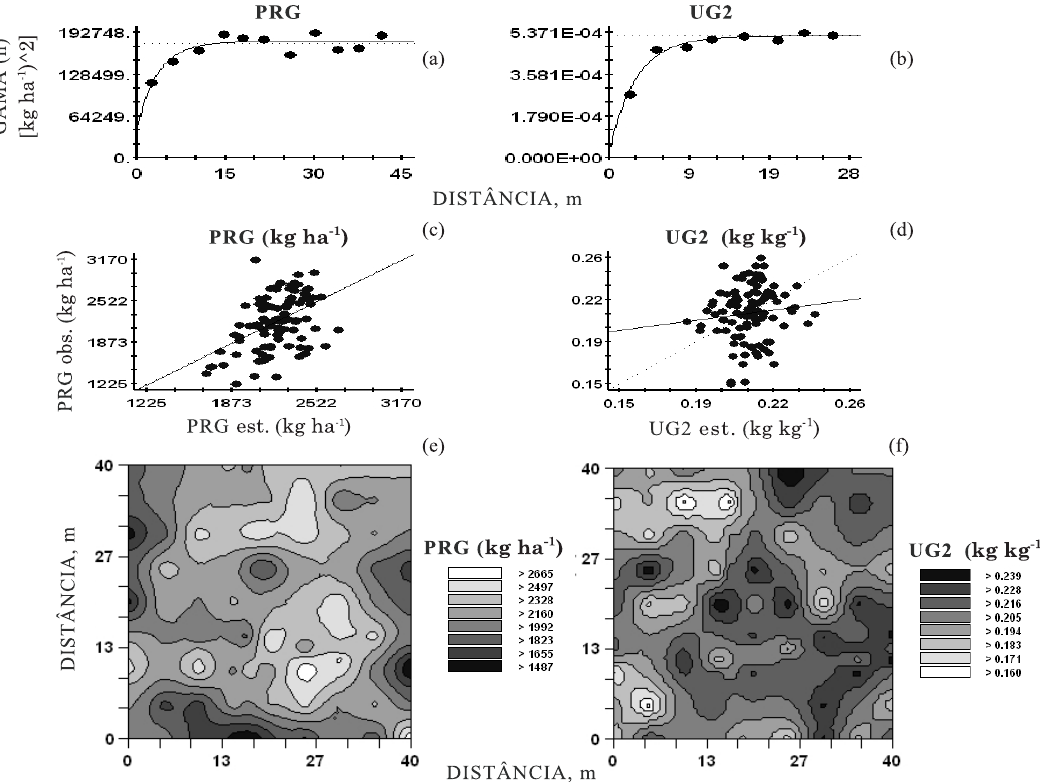
2. Componentes geoestatísticos da produtividade do feijão (PRG) e da umidade gravimétrica (UG2) de um Latossolo Vermelho distroférrico de Selvíria